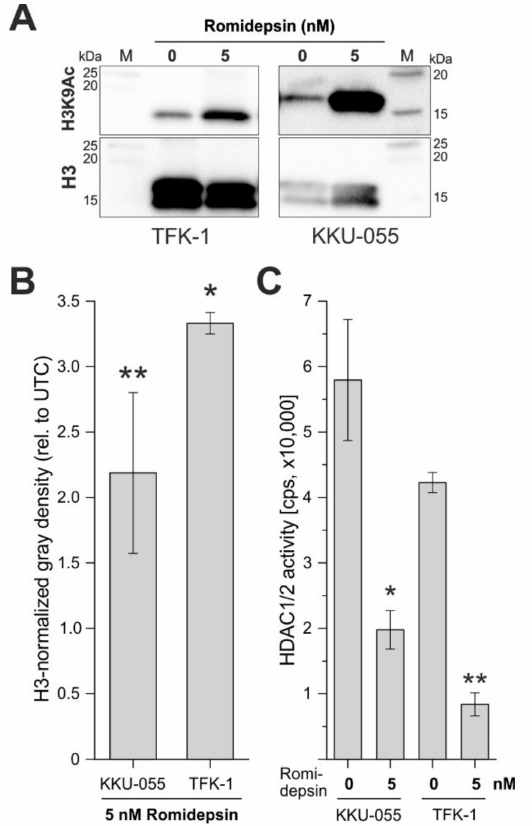
Figure 5. Romidepsin causes H3K9Ac via inhibition of HDAC 1/2 activity. ( A ) Treatment of TFK-1 and KKU-055 cells with romidepsin (5 nM) for 24 h causes an increase in H3K9Ac (representative Western blot images, cropped). ( B ) Quantification of H3K9Ac levels following romidepsin treatment. ( C ) Romidepsin reduces HDAC 1/2 activity in KKU-055 and TFK-1 cells, respectively. HDAC activity was measured using an HDAC-Glo I/II Assay and Screening System (Promega). The protein